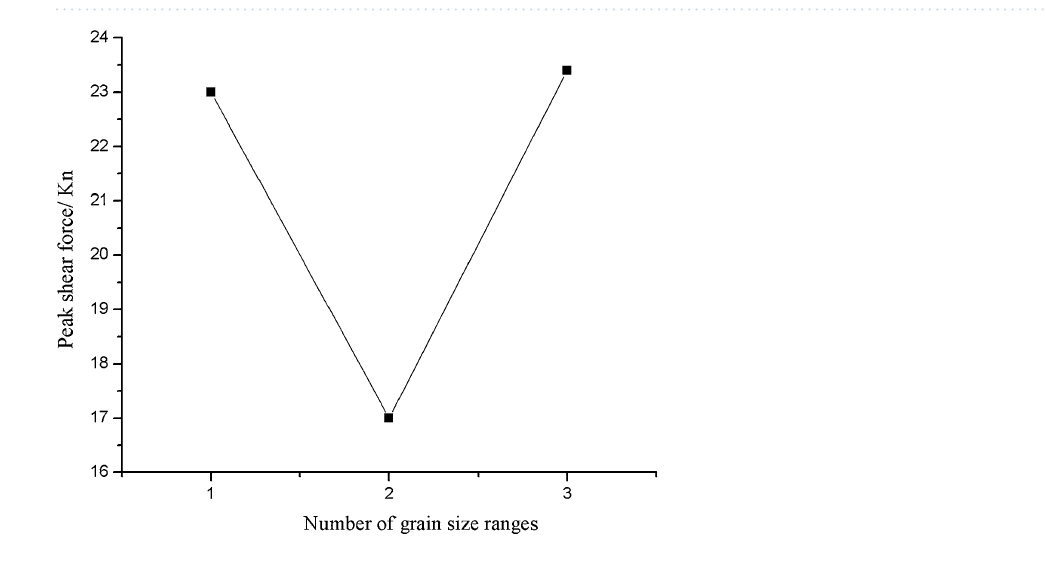
Figure 48. Peak shear stress–number of grain size